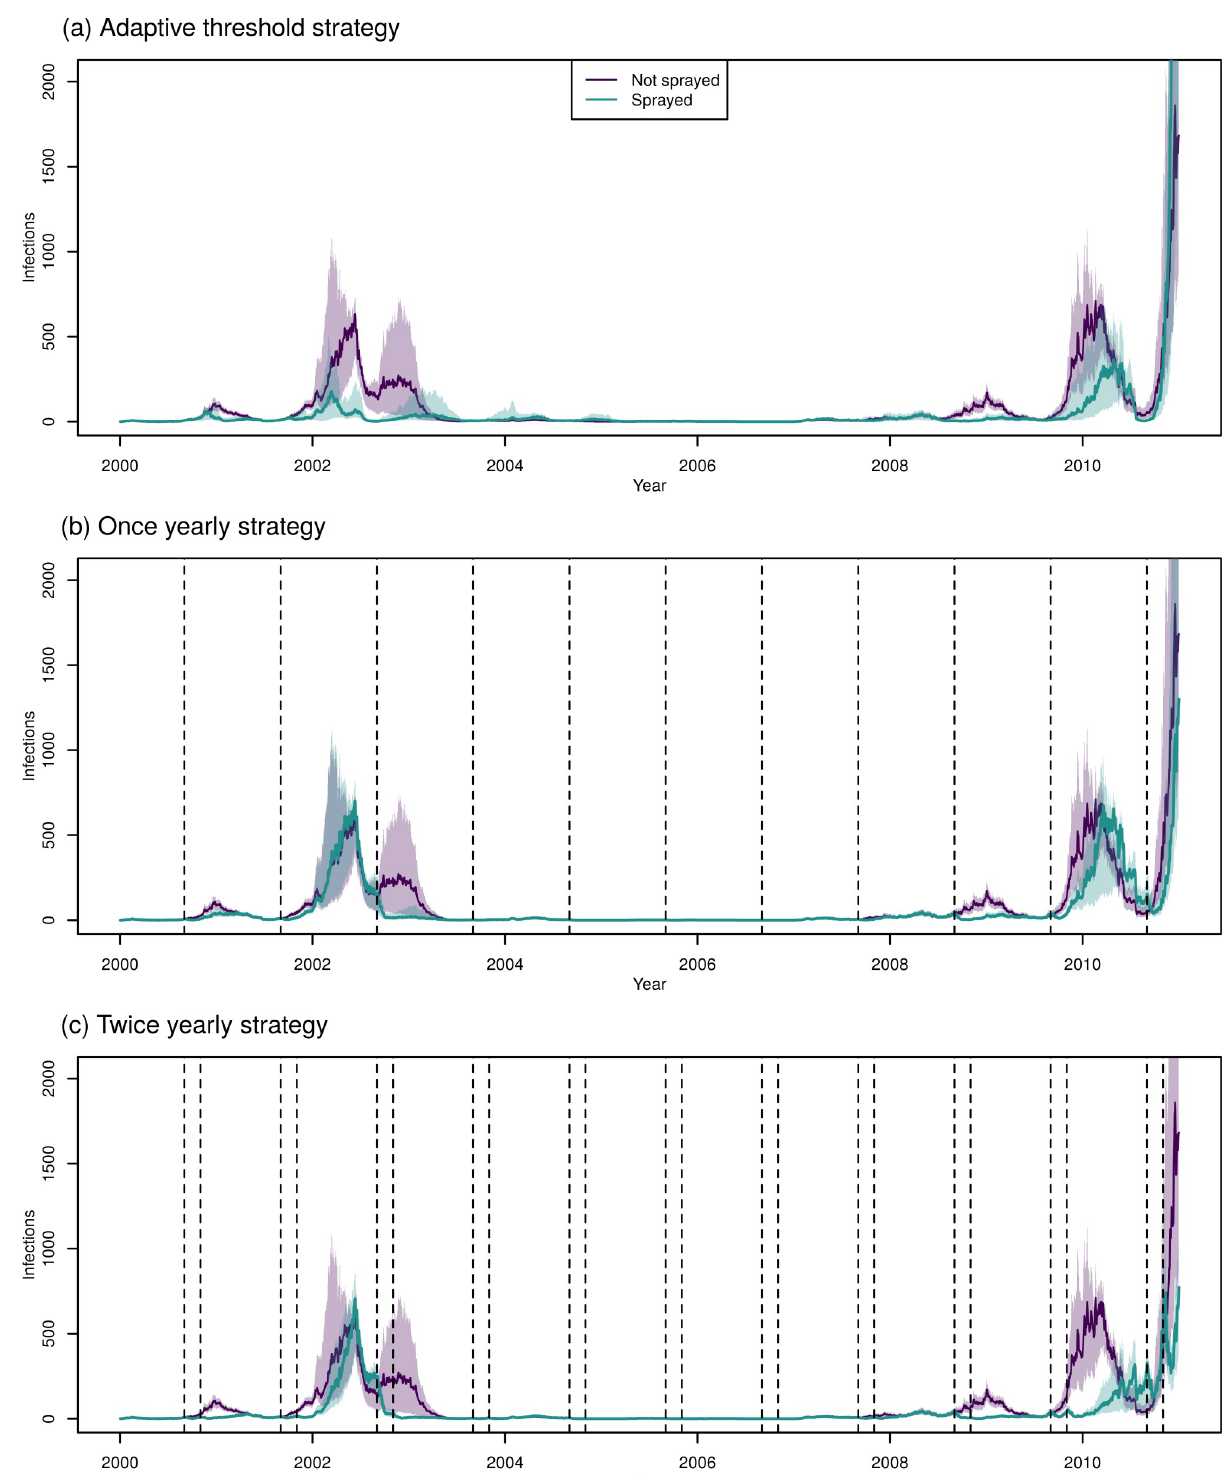
Fig 5. Time-series of incidence of human infections for the best ULV strategy in each category. In each plot, the green lines represent predictions without spraying, and purple represents the given strategy. The line represents the median of all 400 simulations and shading represents the inter- quartile range. The vertical dotted lines represent the start of city-wide ULV campaigns (not displayed for the threshold strategy, as in this case campaigns start at differing times depending on incidence).